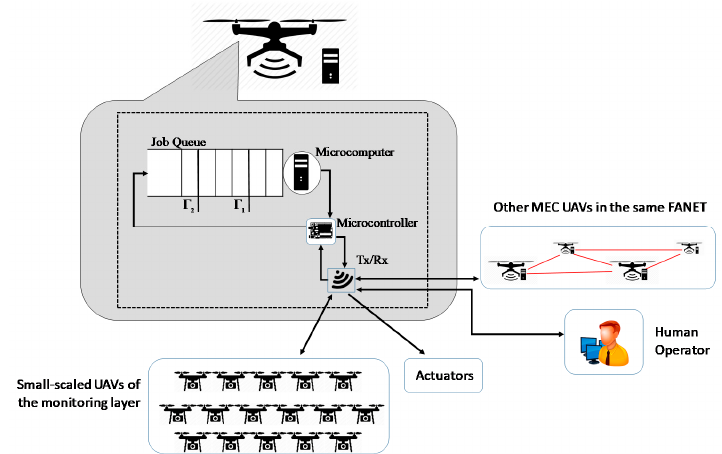
Figure 2. Functional Architecture of a multi-access Edge Computing unmanned aerial vehicles (MEC UAV).